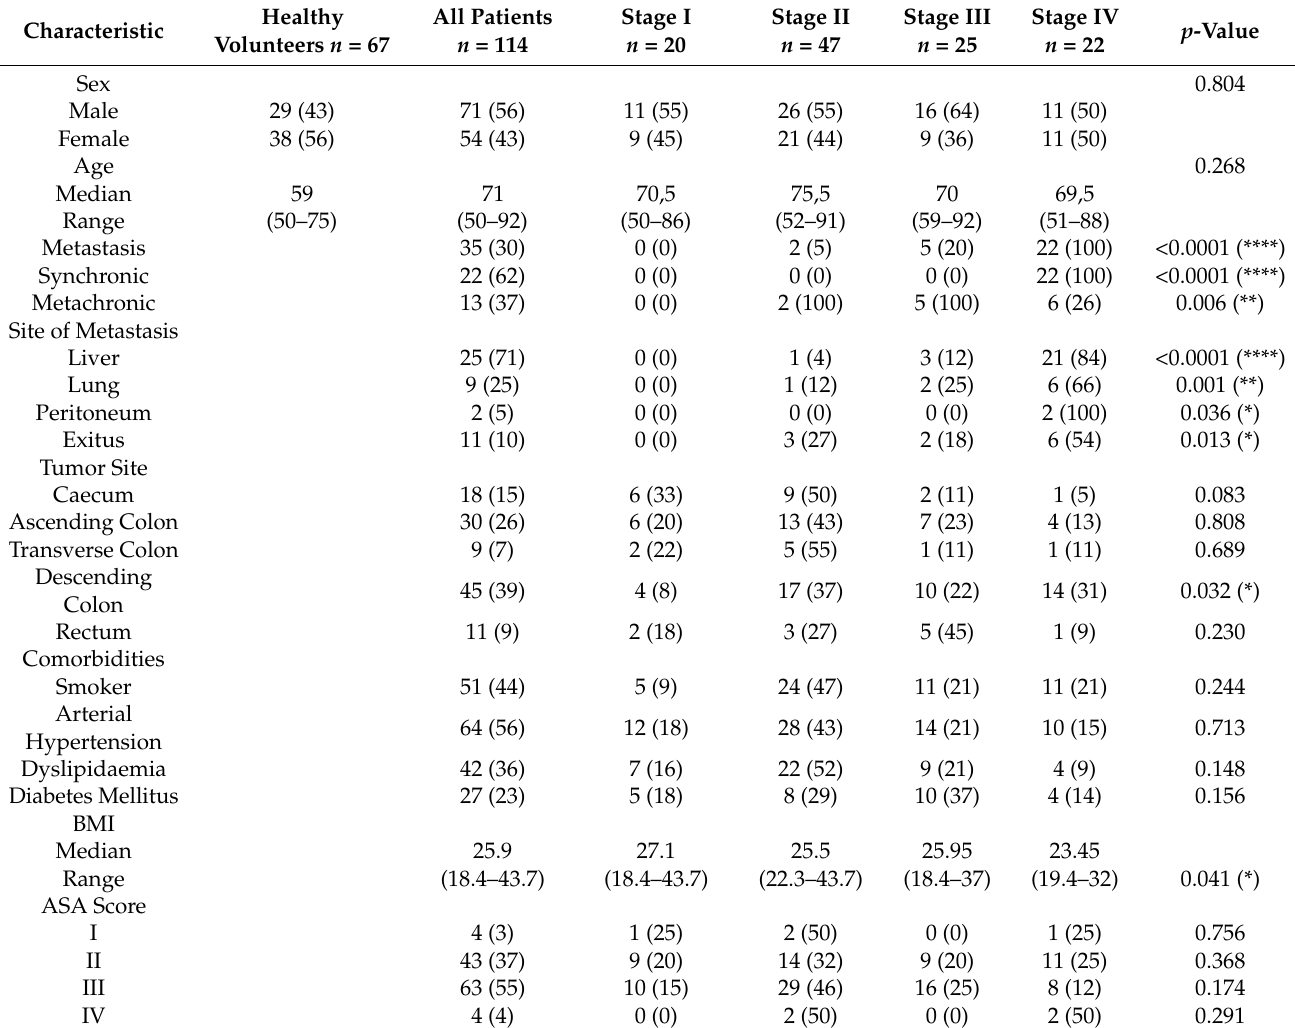
Table 1. Patient and HV characteristics 1 .